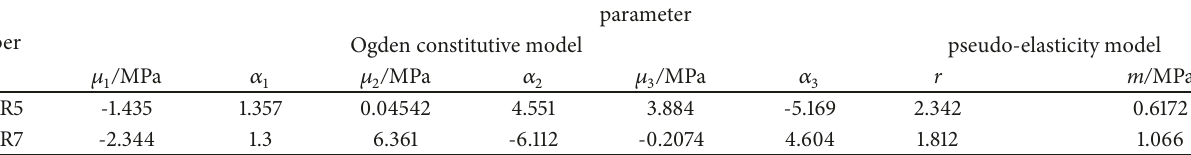
Table 2: Summary of the model parameters for virgin loading curves of NSBR5 and NSBR7.